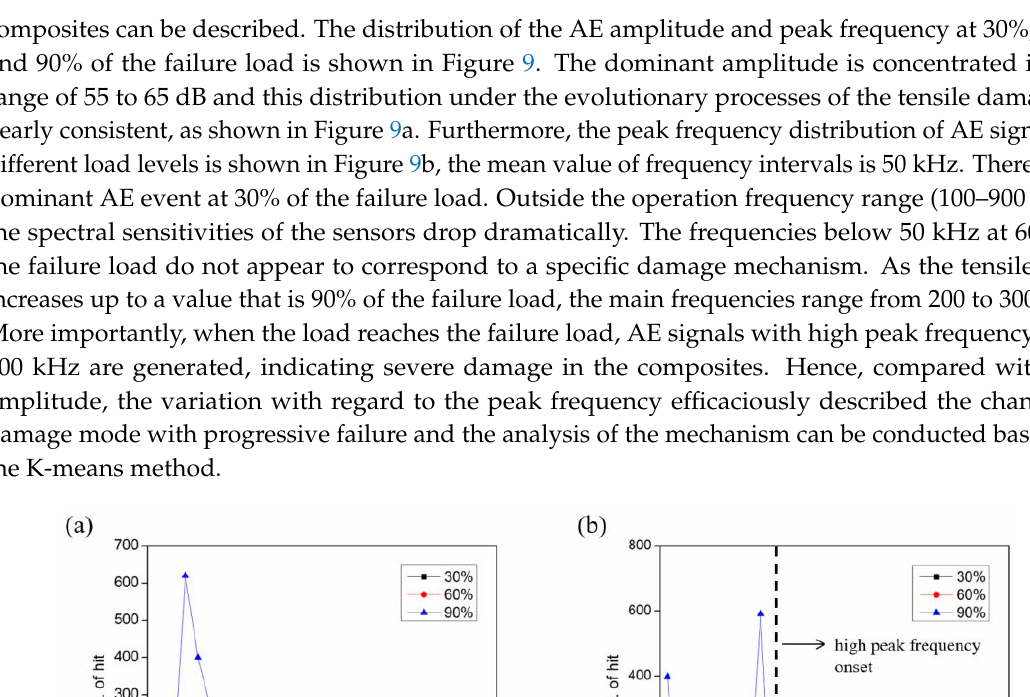
Figure 8. Tensile load, accumulative energy, counts, energy release rate, and AE event count rate vs. time for the composite specimen.